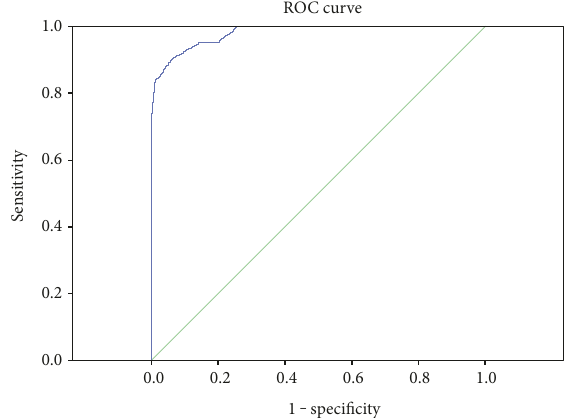
Figure 3: ROC curve of the di ff erentiation model (area under the ROC curve is